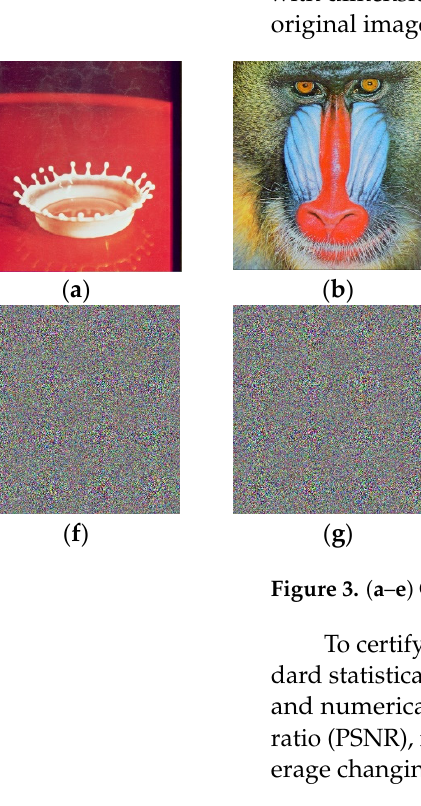
( h ) Figure 4. ( a – d ) Three dimensional histograms of the original Tulip image layers; ( e – h ) respective 3D histograms of cipher image layers. 4.2. Correlation Correlation analysis describes the association among two nearby pixels in an image. An assailant can use a high correlation between adjoining pixels in the enciphered data image to figure out the association among the plain data image and the ciphered image. Accordingly, to assess the scheme ’ s security, a correlation analysis of two neighboring